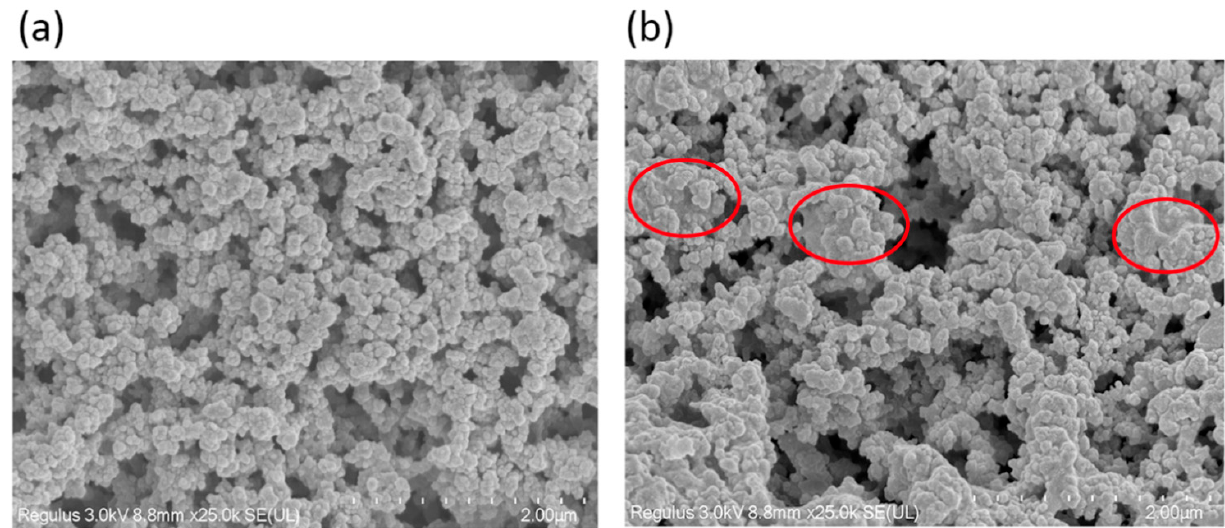
Figure 3. SEM images of the detailed surface structure of ( a ) unblocked and ( b ) blocked immobilised DPEase. The FT-IR image (Figure 4) shows the chemical composition and functional groups of each sample. The peak at 852 cm –1 denoted the characteristic absorption of the epoxy group and no peak of epoxy group was observed in the immobilised enzyme blocked by glycine. Moreover, the O-H bond wavenumbers of the native resin, unblocked, and blocked DPEase were 3442 cm − 1 , 3432 cm − 1 , and 3421 cm − 1 , respectively, indicating that